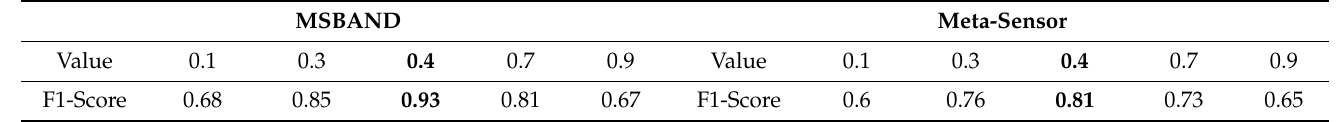
Table 4. Fall_Threshold tuning for MSBAND and meta-sensor datasets, respectively.